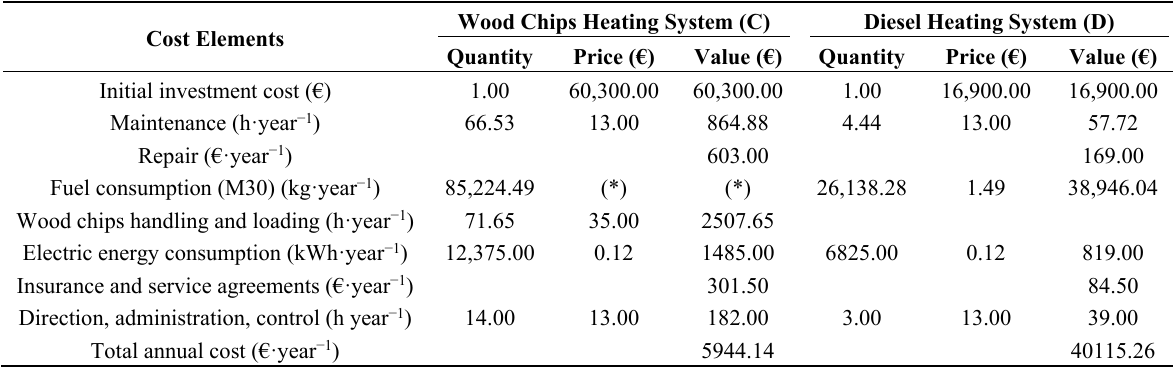
Table 6. Annual cost elements related to the two heating systems considered in the economic comparison and total annual cost of